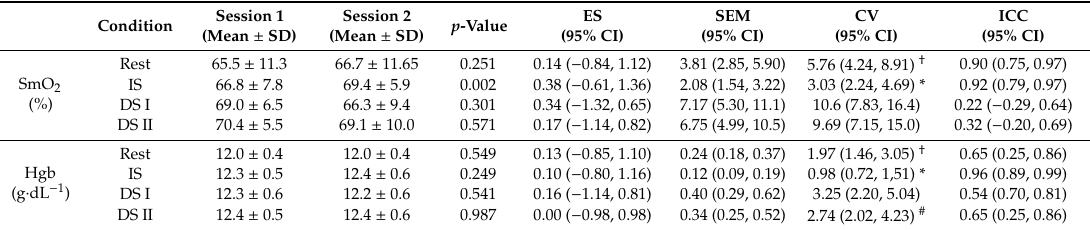
Table 2. Humon Hex NIRS reliability for the determination of SmO 2 and Hgb at rest, isometric and dynamic strength protocols I and